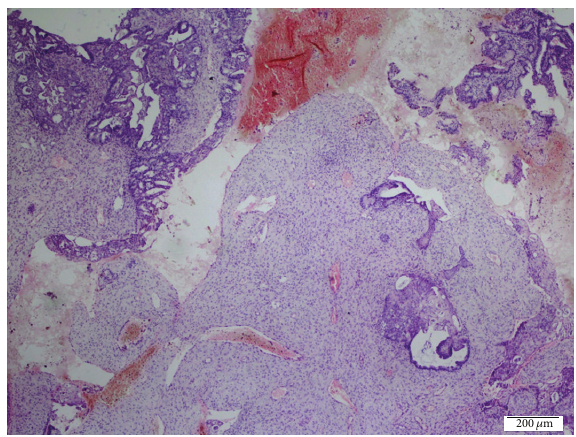
Figure 1: The nests of well differentiated endometrial carcinoma in the decidual reaction (HE ×